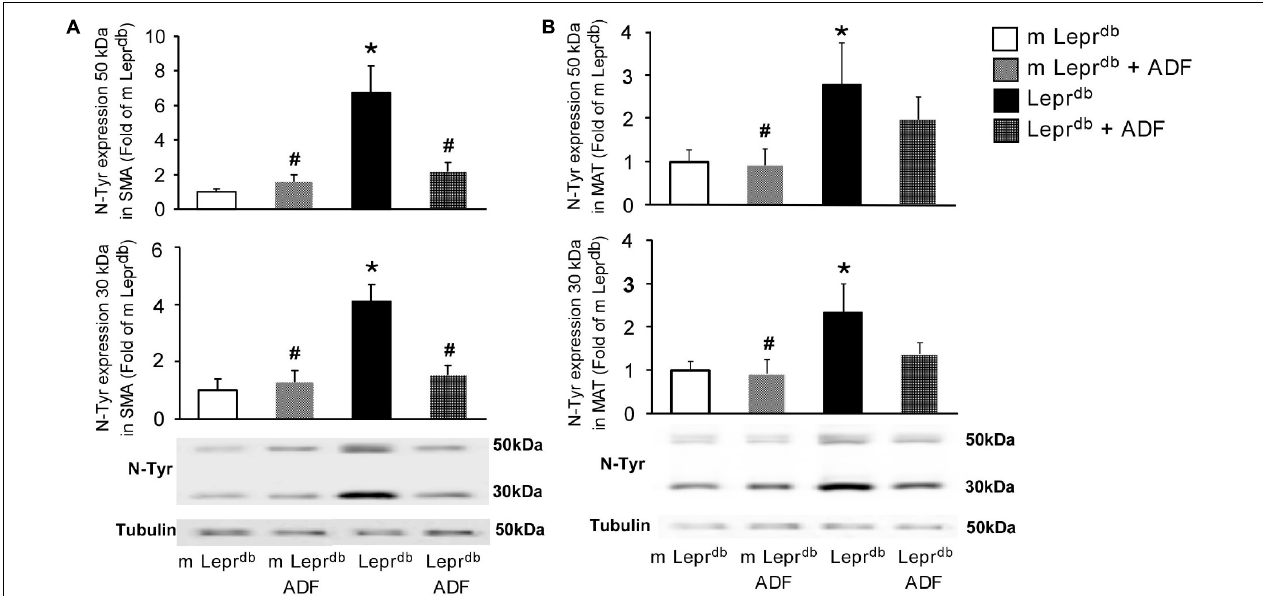
FIGURE 5 | ADF reduced nitrotyrosine protein levels in SMA, but not MAT, of Lepr db mice. (A) Nitrotyrosine protein levels were higher in SMA of Lepr db mice. ADF reduced nitrotyrosince protein in SMA of Lepr db mice. n = 4 mice per group. (B) Nitrotyrosine protein levels were higher in MAT of Lepr db mice. ADF did not alter nitrotyrosince protein in MAT of Lepr db mice. n = 6 mice per group. * P < 0.05 vs. m Lepr db control mice, # p < 0.05 vs. Lepr db diabetic